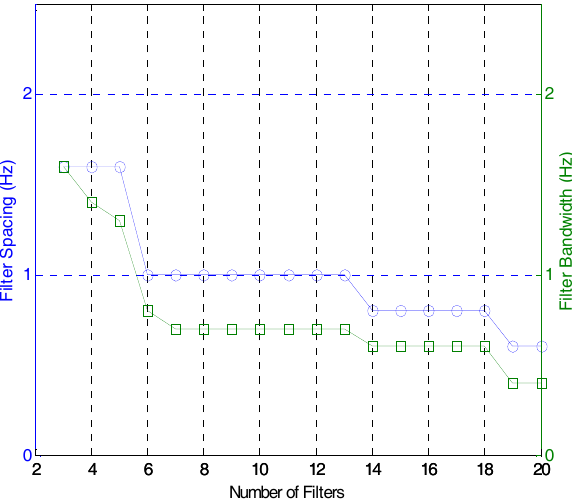
Figure 8. Bandwidth and filter spacing for different numbers of filters.